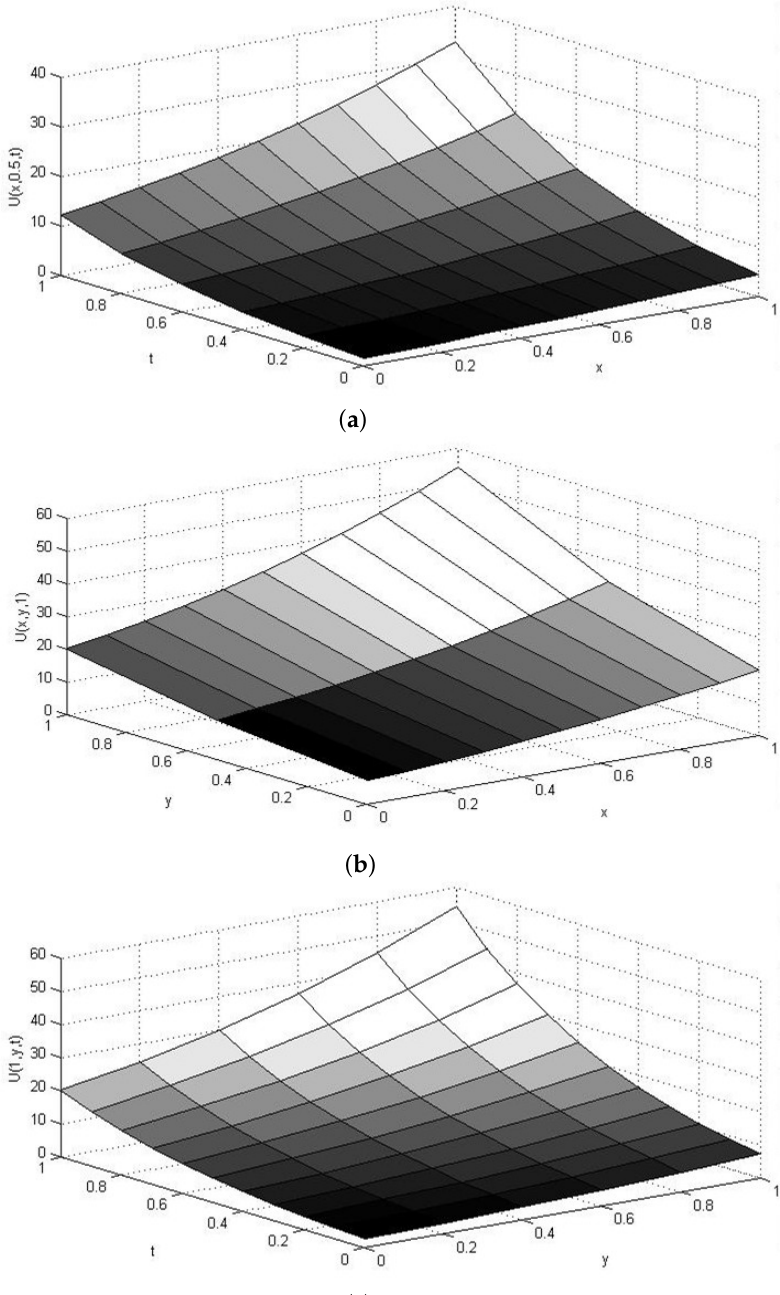
Figure 2. ( a ) The HPSTM solution at y = 0.5. ( b ) The HPSTM solution at t = 1. ( c ) The HPSTM solution at x =